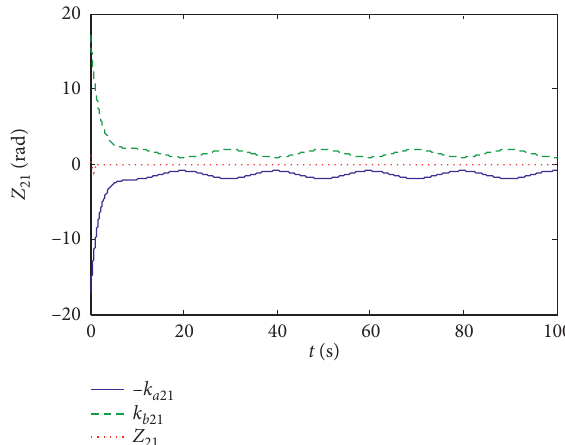
Figure 10: Constraint effect of Z